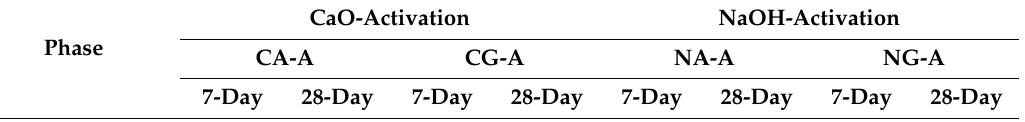
Figure 4. XRD patterns at ( a ) 7 days and ( b ) 28 days. The symbols ■ and ▼ indicate the first and the second peak of remaining gypsum at 28 days, respectively; XRD peaks of akermanite: 28.934 [23.1%], 30.150 [100%]. Table 4. Identified phases with relative intensities in XRD for hardened samples.